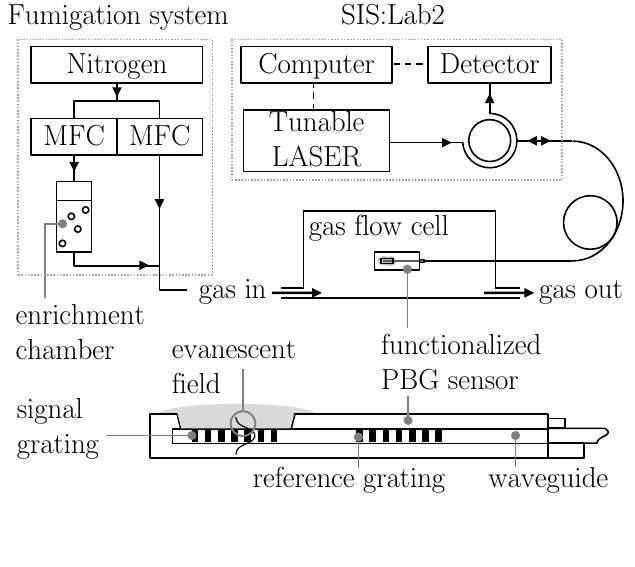
Figure 1. Schematic representation of the experimental setup with an additional longitudinal cross section of the